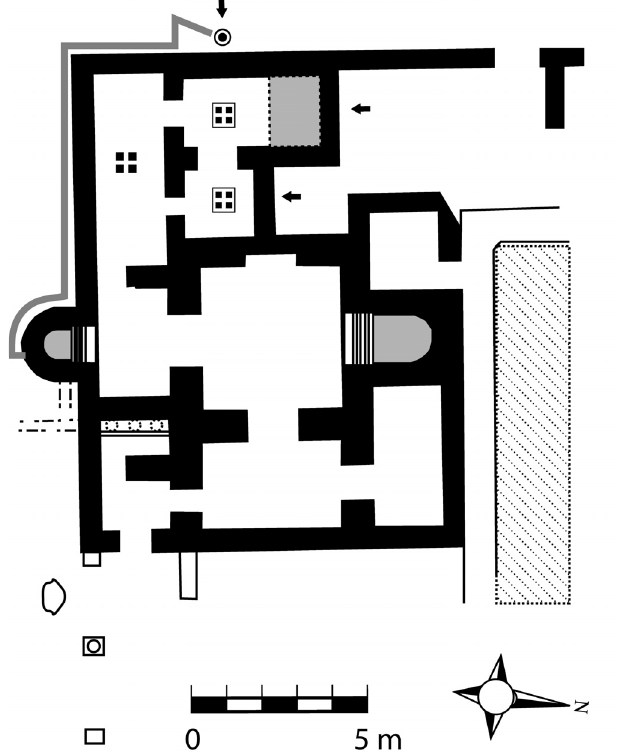
Figure 7: The baths in Henchir Sa fi a (after Lassus 1959, general